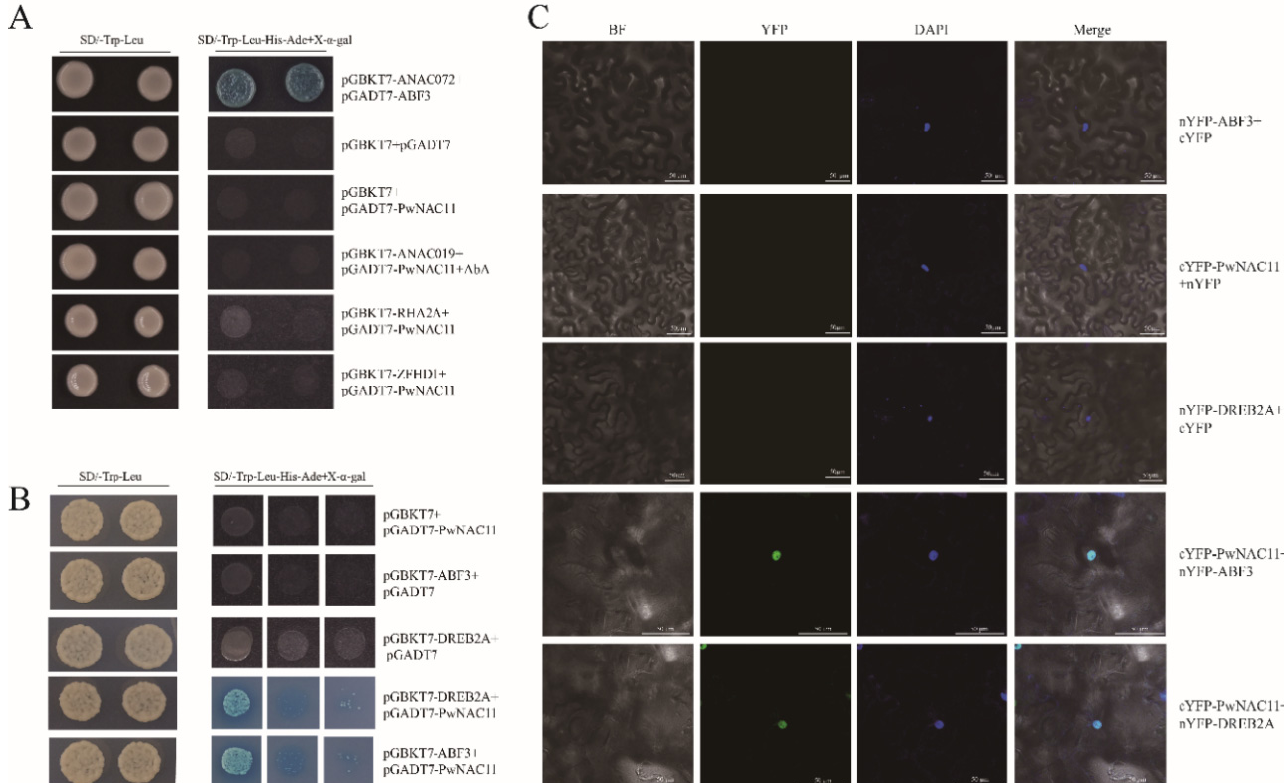
Figure 7. PwNAC11 interacts with ABF3 and DREB2A. ( A ) Yeast two-hybrid assays for PwNAC11 with ANAC019, RHA2A and ZFHD1. The yeast strains containing pGADT7-ABF3 and pGBKT7-ANAC072 fusion plasmids were used as positive control. Empty pGADT7 and pGBKT7 were used as negative control. ( B ) Yeast two-hybrid assays for PwNAC11 with ABF3 and DREB2A. ( C ) BiFC assays for PwNAC11 and ABF3/DREB2A interactions. Bars represent 50 µ m. The C-terminal or N-terminal of YFP was used as negative control.